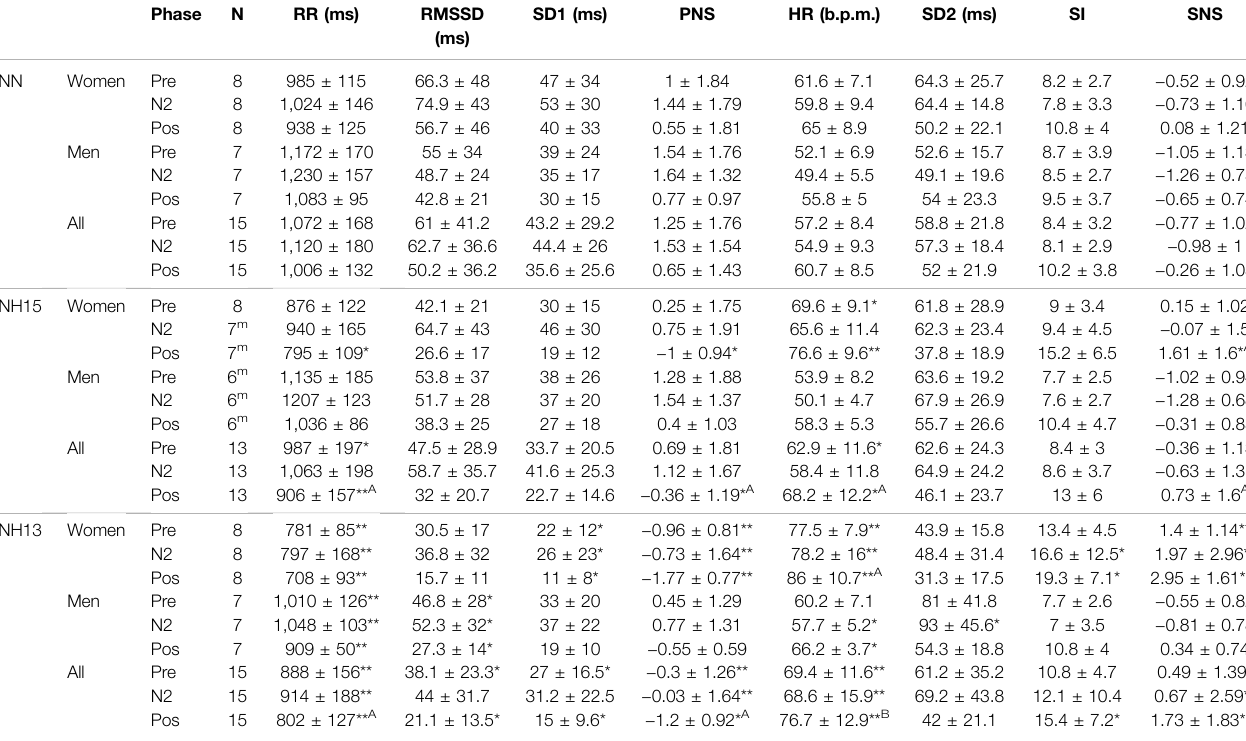
TABLE 2 | Heart rate variability parameters during a daytime nap in normobaric normoxia (NN) and normobaric hypoxia (NH15: FiO 2 14.7, NH13: FiO 2